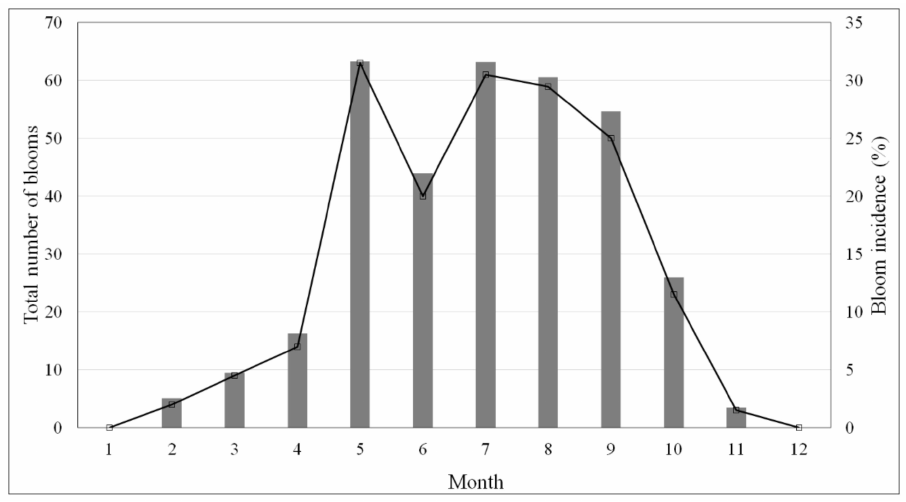
Figure 2. Monthly distribution of the total number of blooms of Pseudo-nitzschia spp. (black line, left axis) and bloom incidence (grey bar, right axis) for the Galician Rias Baixas from 2002 to 2012.